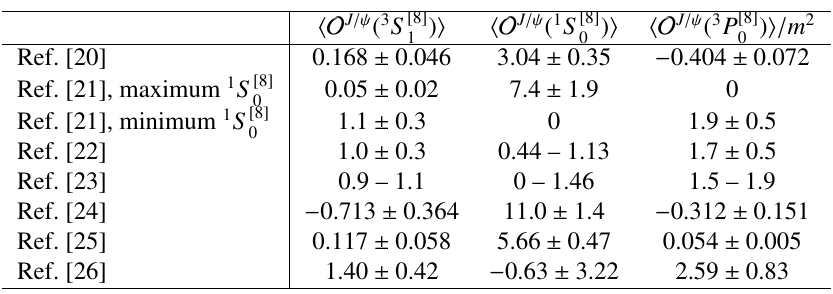
Table 1. Phenomenological determinations of J /ψ color-octet matrix elements in units of 10 − 2 GeV 3 from refs. [20–26]. In ref. [21], only two linear combinations of the three matrix elements are determined, and the maximum ranges of the matrix elements are obtained from maximizing and minimizing ⟨O J /ψ ( 1 S [8] ) ⟩ under the assumption made in ref. [21] that the matrix elements are positive 0 definite. Refs. [24, 26] provide covariance matrices from which the correlations in the uncertainties can be obtained. The pNRQCD result from ref. [26] is from the analysis with p T larger than 5 times the heavy quarkonium mass.